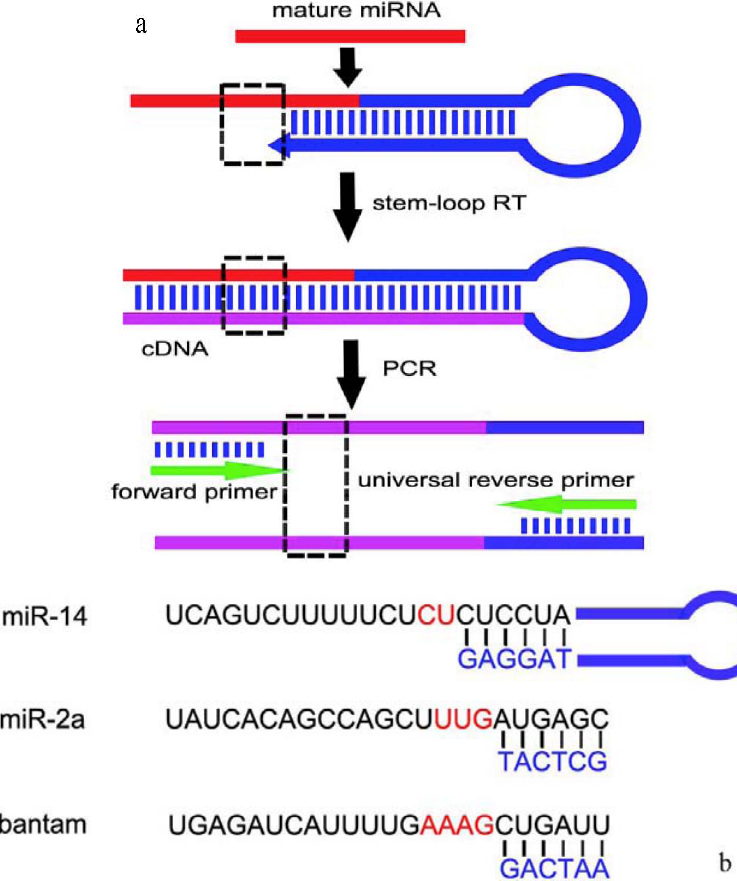
Figure 6. The principle of stem-loop RT-PCR in present paper: ( a ) Stem-loop primer was designed to increase the length of mature miRNAs. PCR forward primer was designed by putative miRNAs, the universal reverse primer was designed by stem-loop primer. The box formed by dotted line represents the bases not included in primers; ( b ) Six nucleotides of 3 ′ end of stem-loop RT primer are complementary with 3 ′ end of mature miRNAs of D. melanogaster . Two bases, three bases and four bases were not included in RT-PCR primers of miR-14 , miR-2a and bantam , respectively (colored red), thus miRNAs or non-specific amplification could be distinguished by sequence